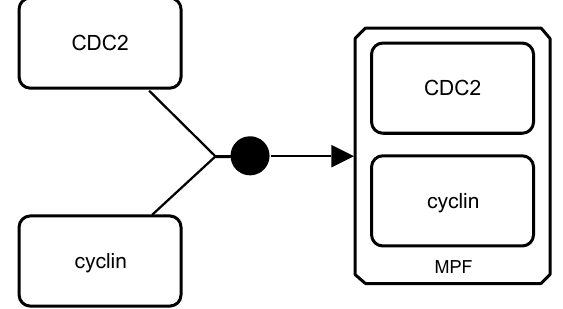
Figure 2.32: Association of cyclin and CDC2 kinase into the Maturation Promoting